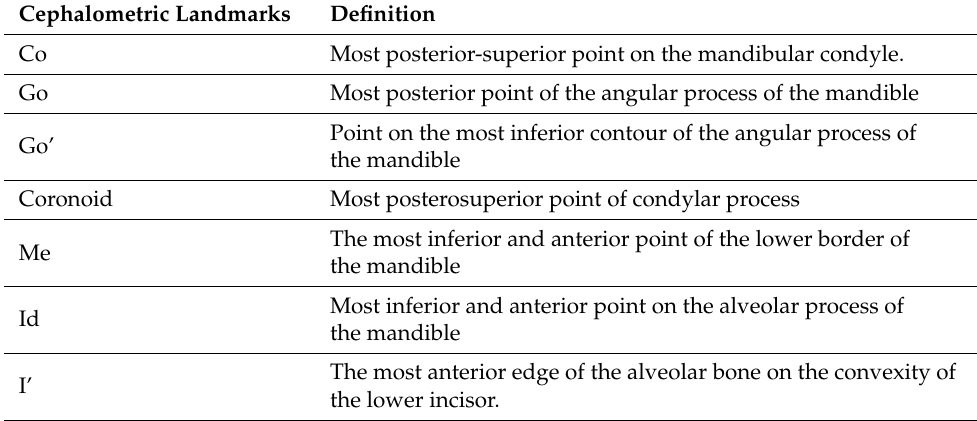
Table 1. Cephalometric landmarks used for linear